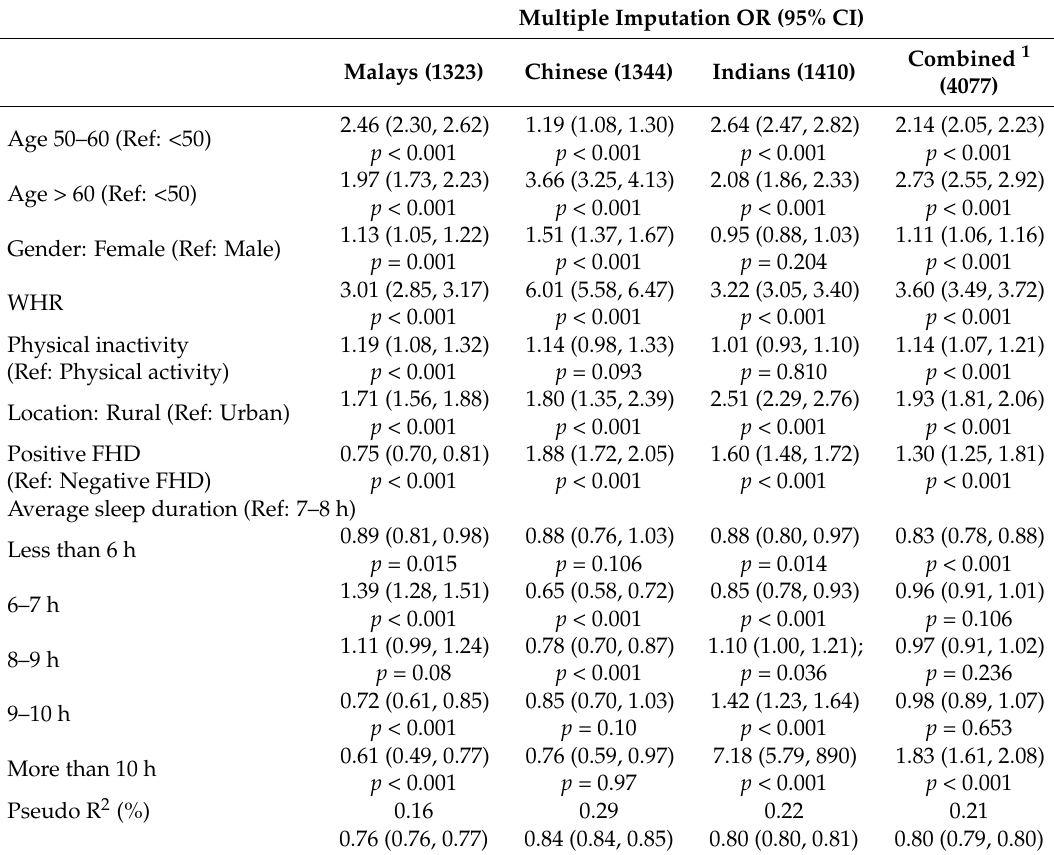
Table 3. Odds ratios, 95% confidence intervals and p -values from multiply imputed data (n =